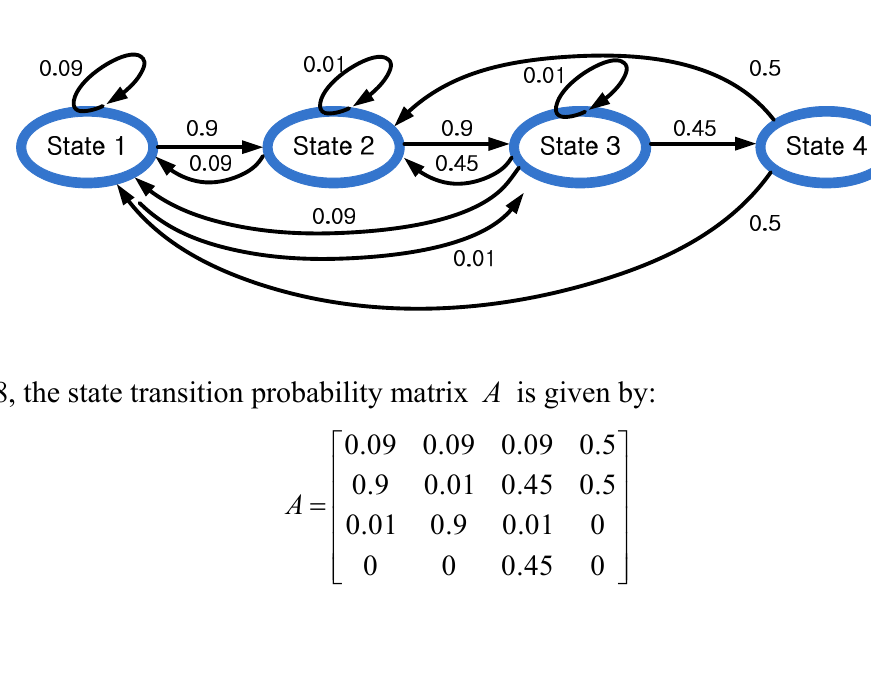
Figure 8. The state transition